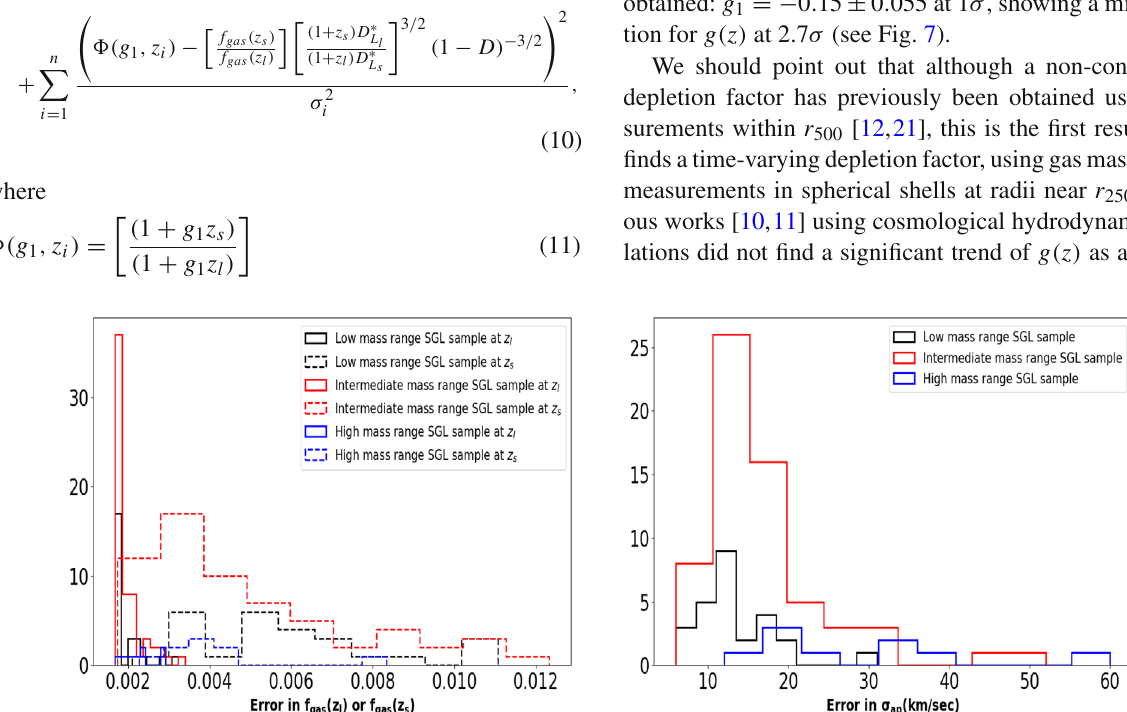
Fig. 3 (Left) The distribution of error in f gas for Low, Intermediate, and High mass range sample at z l and z s . (Right) The distribution of error in σ ap for Low, Intermediate, and High mass range SGL